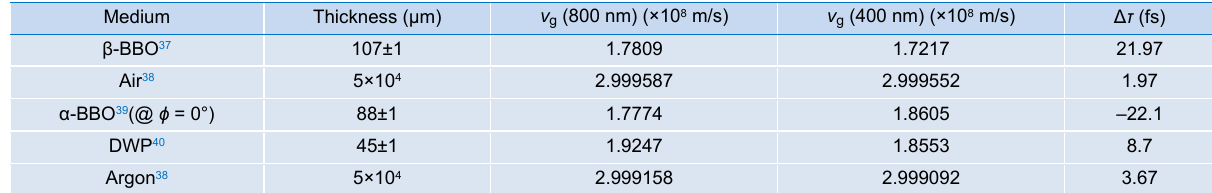
Table 2 | Calculated temporal delay between two beams in the